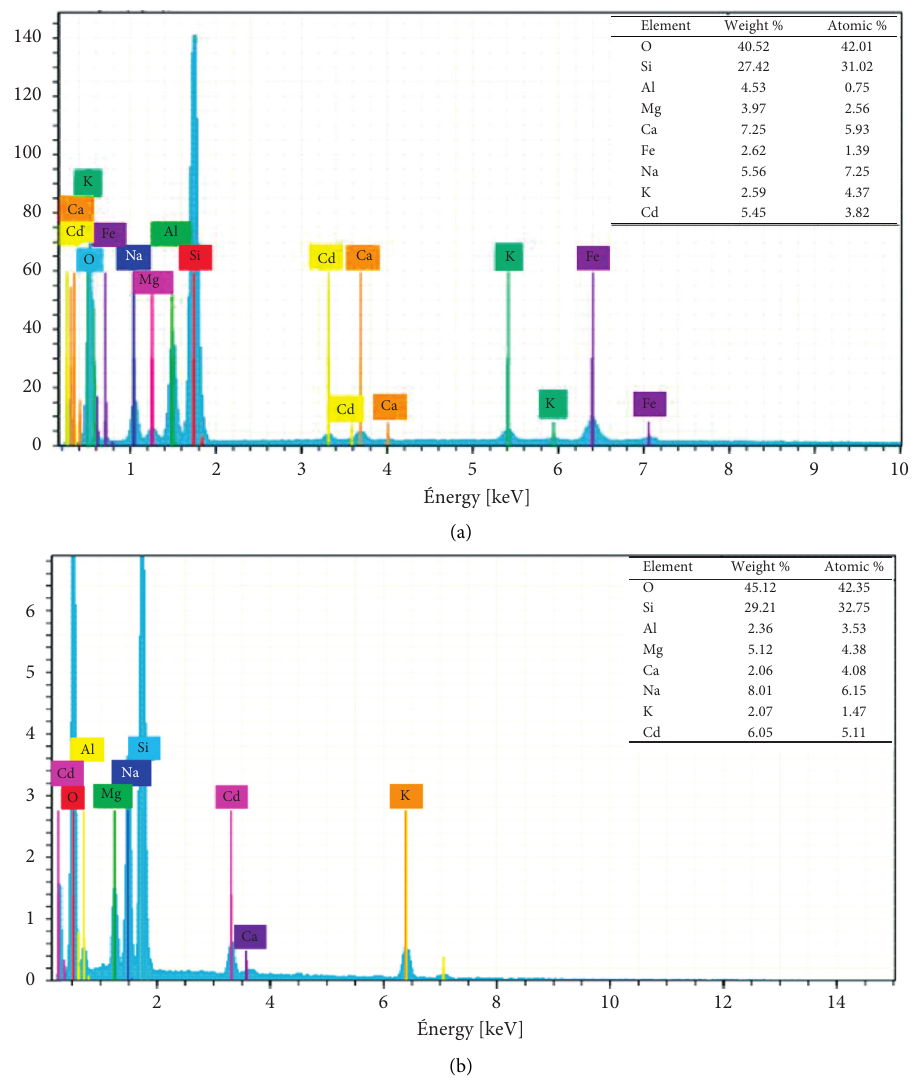
Figure 15: EDX analysis of (a) QC-MC and (b) QC-MT after adsorption of Cd (II).